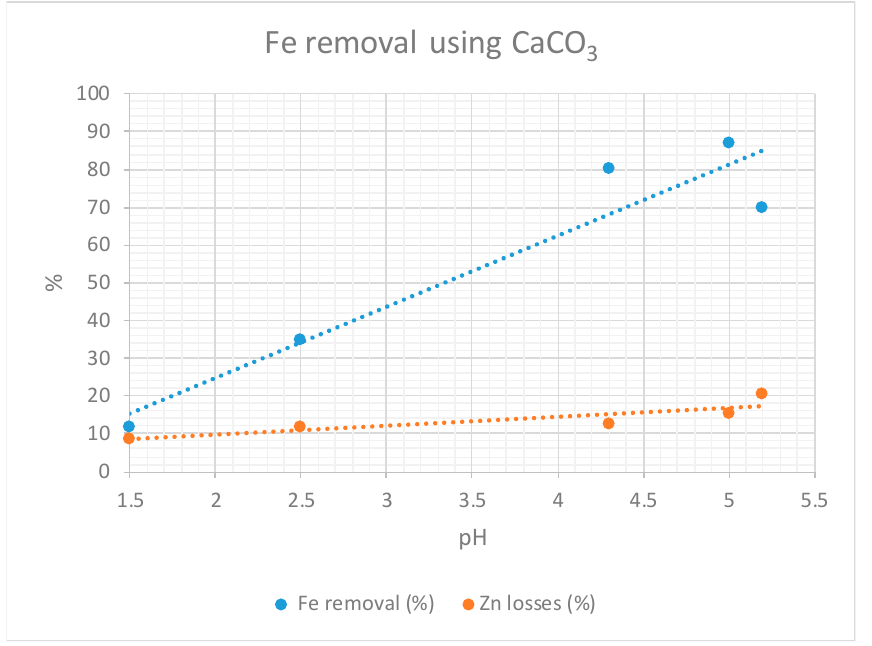
Figure 11. Exploratory test results using CaCO 3.